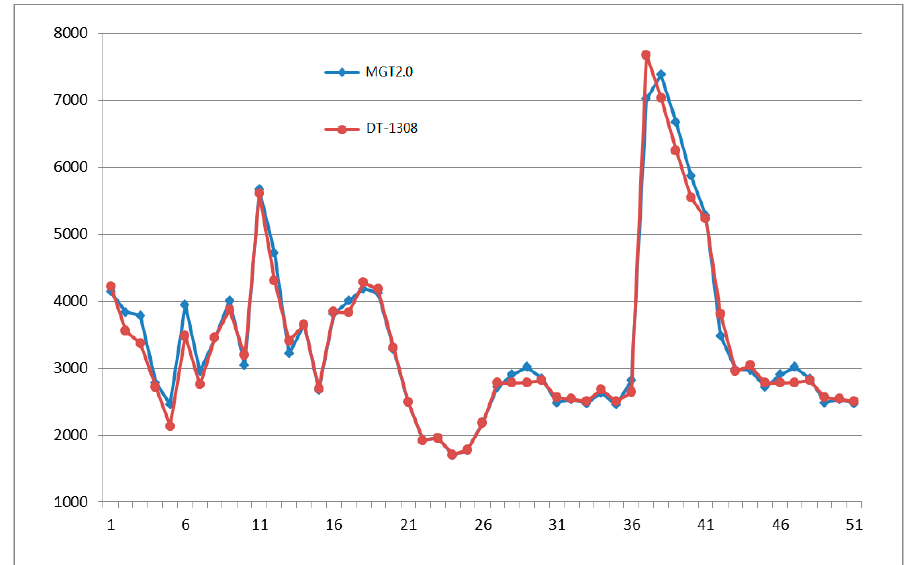
Figure 13. Fifty light intensity (Lx) experimental results by MGT2.0 (marked by blue line) and DT-1308 (marked by red line).